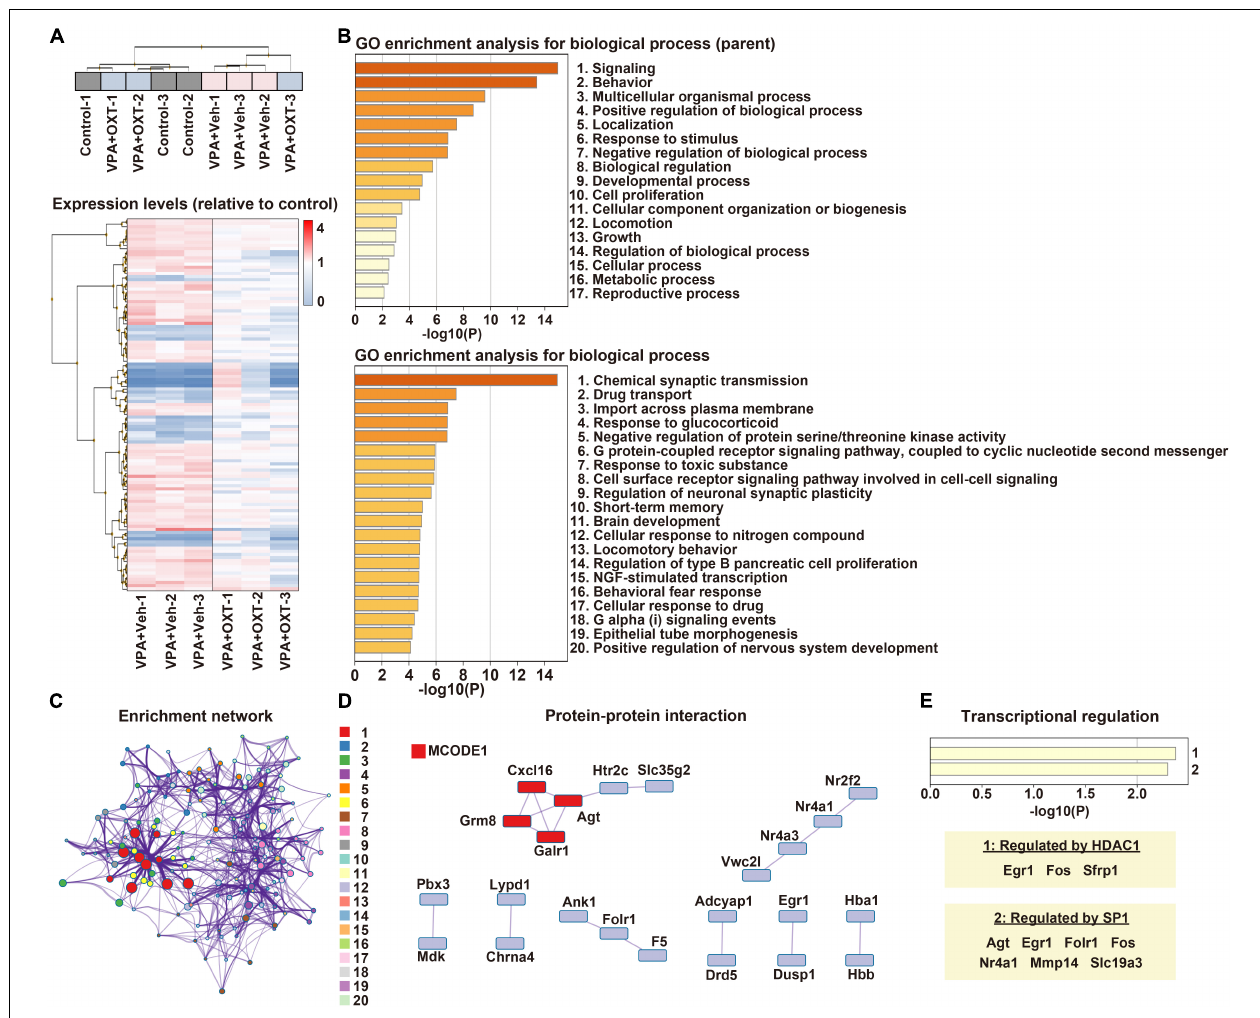
FIGURE 1 | Transcriptome profiling in the hippocampus of prenatally VPA exposed rats. (A) Hierarchical clustering of DEGs between groups. Expression levels were normalized to those of the control. (B) Biological processes of DEGs in GO enrichment analysis. Top, parent; Down, child annotations, respectively. (C) Enrichment networks between clusters of biological processes. Shown numbers are the same with those of child annotations in panel (B) . (D) Protein-protein interactive networks between DEGs. Shown by MCODE1 represents a strongly connected network. (E) Analysis of transcriptional regulation of DEGs. HDAC1 and SP1 are detected as significant regulators. VPA, valproic acid; DEG, differentially expressed gene; GO, gene ontology; MCODE1, molecular complex detector; HDAC, histone deacetylase; SP1, specificity protein